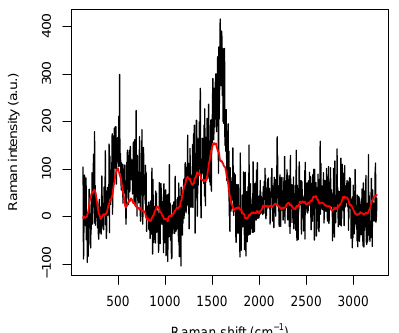
Figure 1. Comparison between a raw Raman spectrum and the curve (in red) obtained by performing Savitzky–Golay